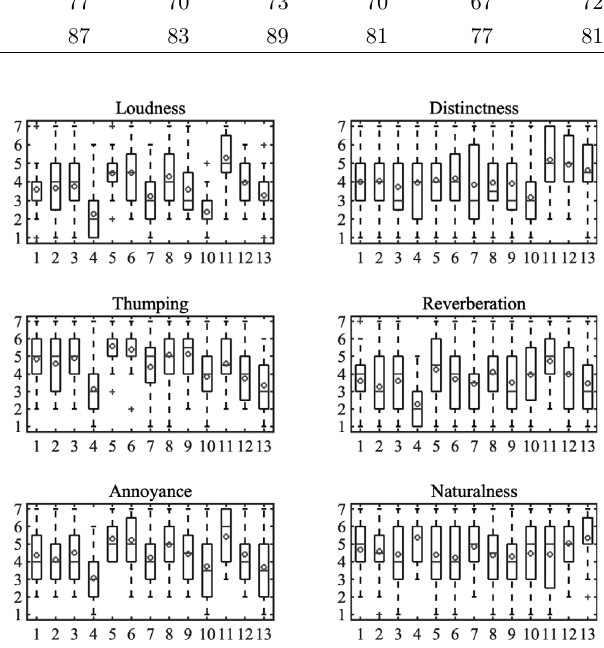
Figure 12. Listening test results for all the participants and all sound samples. The horizontal axis represents the fl oor sample, and the vertical axis shows the rating values. The circles show the mean values of the data for each sound sample in each